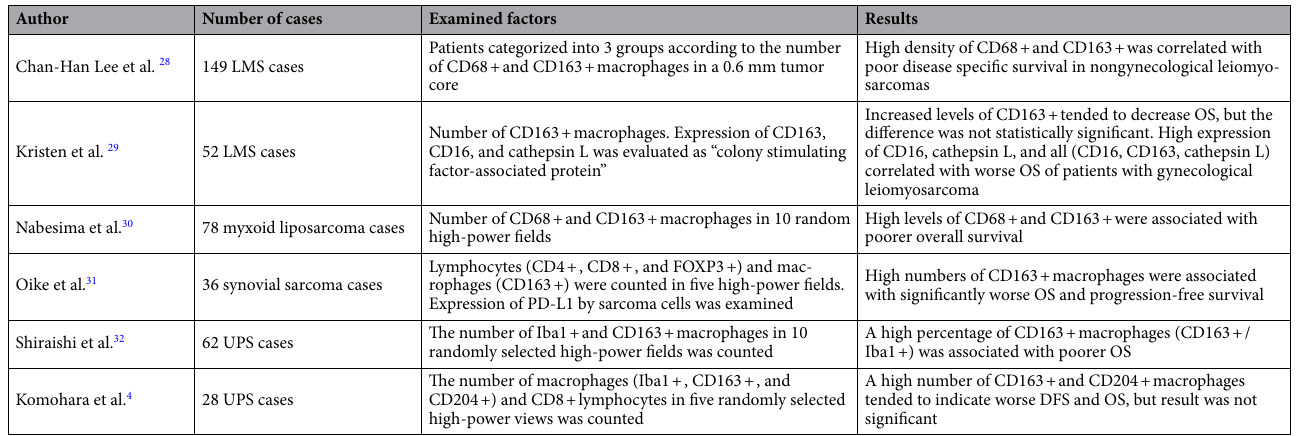
Table 5. Review of the literature regarding the association between TAMs in sarcoma and clinical outcome. LMS, leiomyosarcoma; UPS, undifferentiated pleomorphic